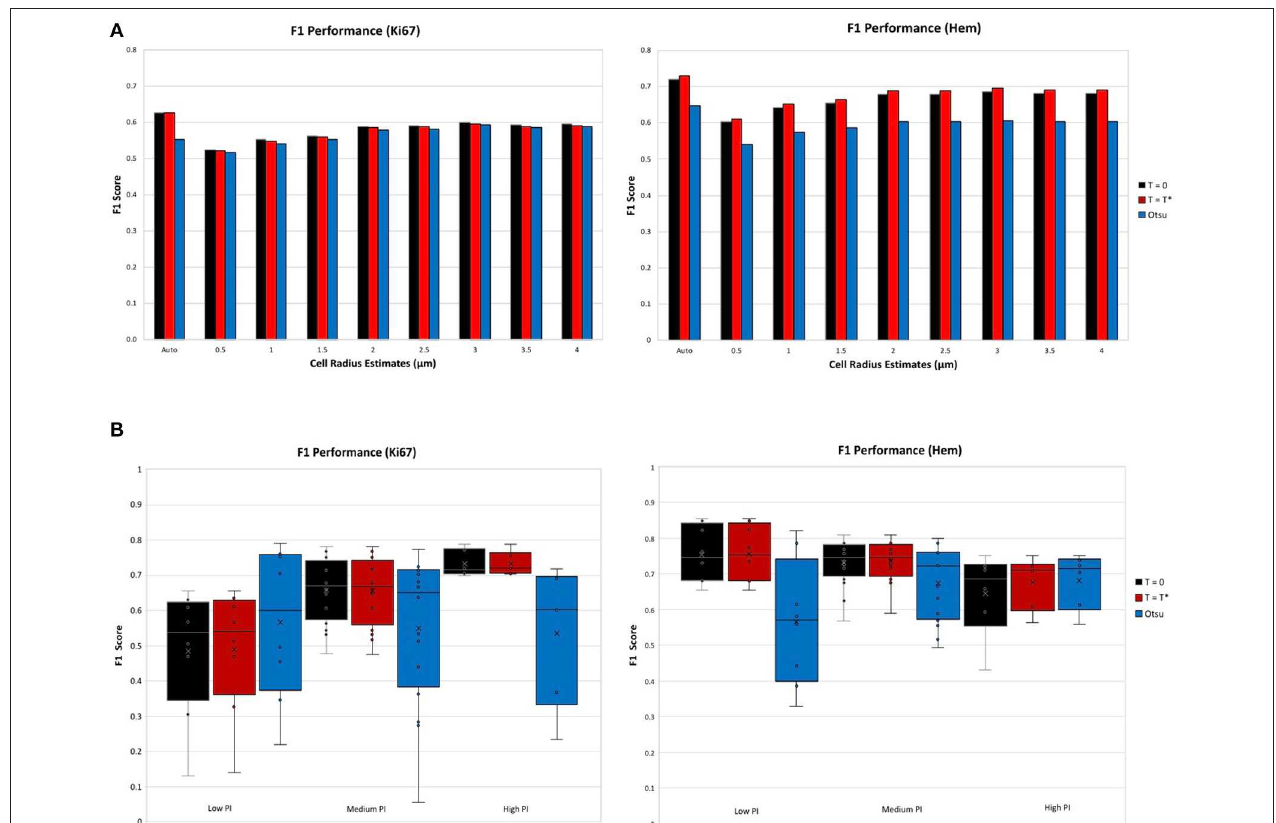
FIGURE 7 | F1 scores for nuclei detection for each threshold, per stain. (A) F1 scores comparison of automatic cell radius estimator per thresholding condition. (B) F1 performance of automatic thresholding condition, in ranges of low, medium, and high PI.